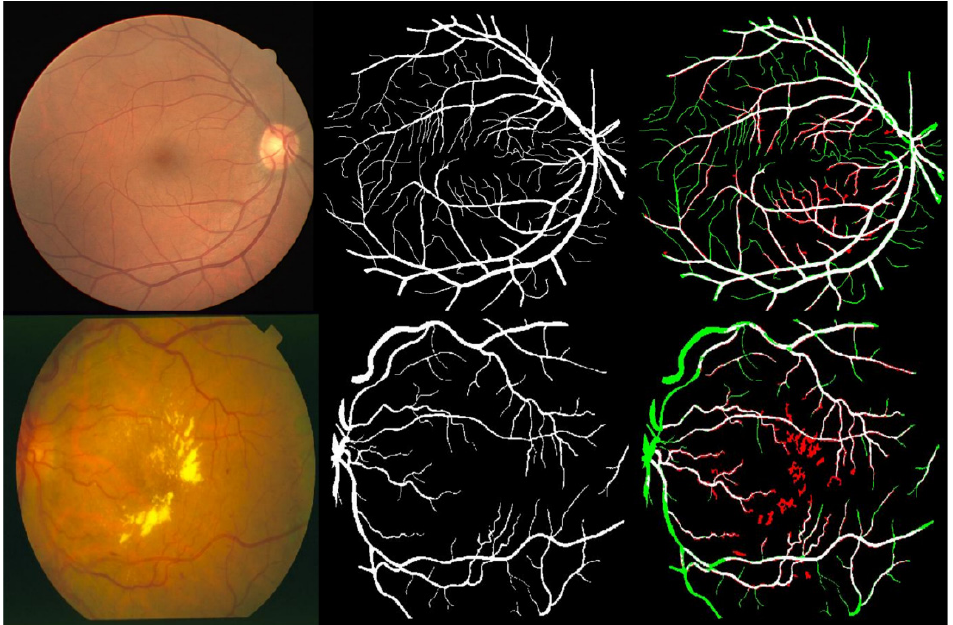
Figure 2. Best case accuracy: First column represents color images, second ground truth and third segmented images. First row contains DRIVE images, and STARE images are there in the second row. Last column: white indicate the pixels of true positives; while the green pixels denote the missed vessel pixels, whereas red are false positives.